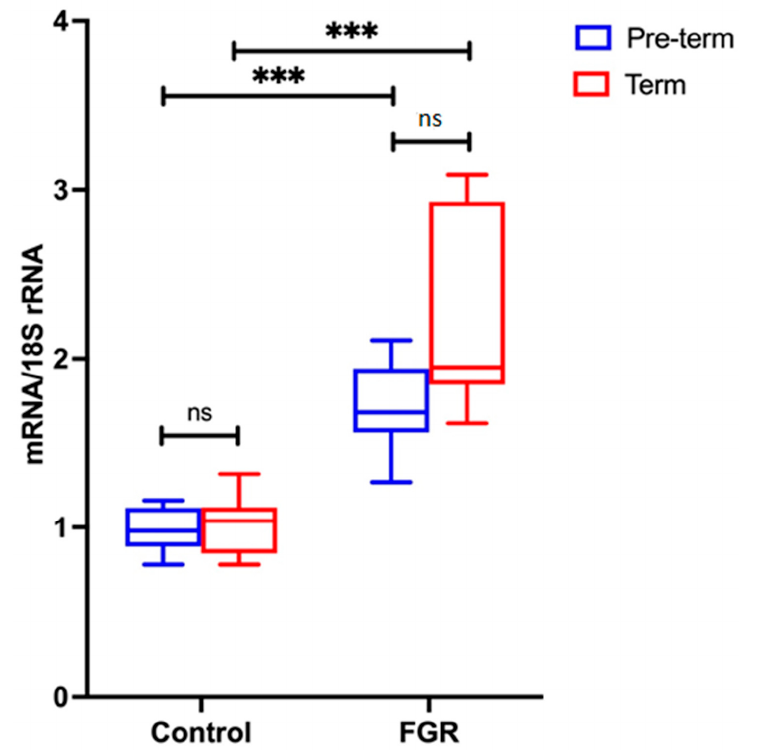
Figure 3. NLRP3 mRNA expression in pre-term and term groups. Data from the pre-term group are shown in blue; from the term group in red. A Mann–Whitney U test was performed to determine statistical differences between the groups. Statistical significance is denoted by *** p < 0.001 vs. corresponding group indicated. Non-statistical significance is denoted by